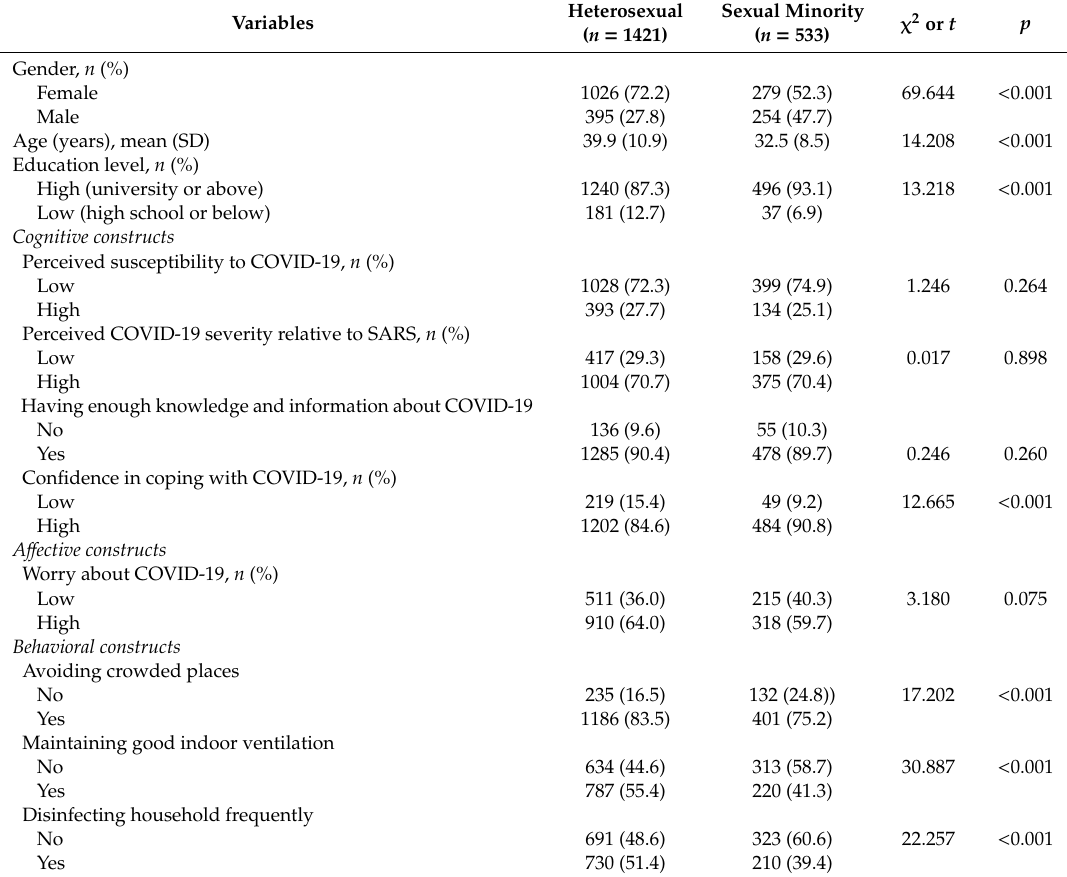
Table 1. Comparisons of demographic characteristics and cognitive, a ff ective, and behavioral constructs of health belief related to COVID-19 between sexual minority and heterosexual participants ( N =